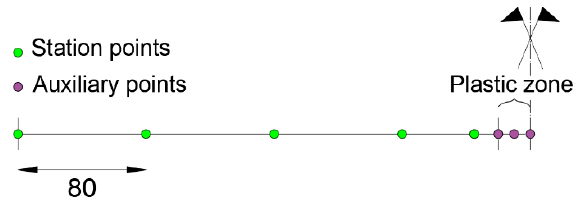
Figure 20. Modeling scheme for the proposed procedure. The final diagrams of the displacements and curvatures obtained after performing step (3) are shown in Figure 21.